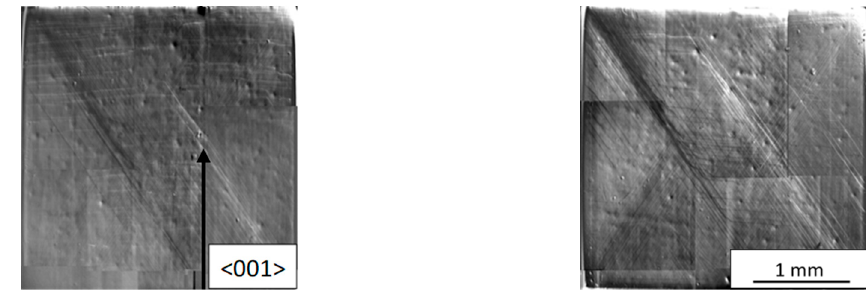
Figure 10. Deformation patterns on the {110} lateral faces of an Al single crystal. Compression was carried out along the <001> axis; h/d = 2, ε = 13%.